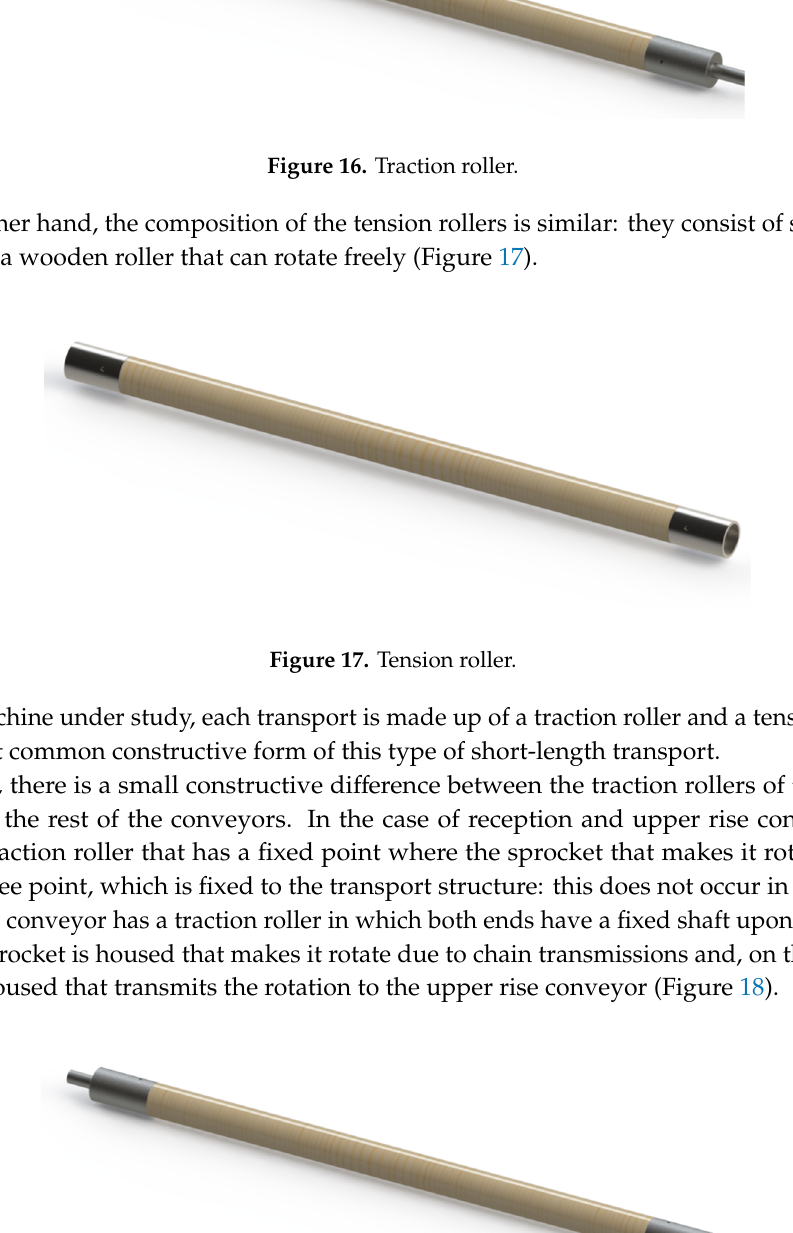
Figure 18. Traction roller of the lower rise conveyor.